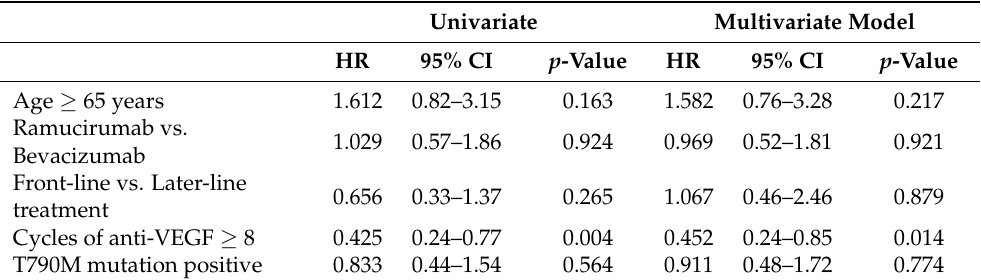
Table 3. Univariate and multivariate analyses of clinical factors associated with overall survival of EGFR-mutated metastatic non-small-cell lung cancer patients receiving bevacizumab or ramucirumab in combination with epidermal growth factor receptor-tyrosine kinase inhibitor therapy as first-line or later-line treatment.